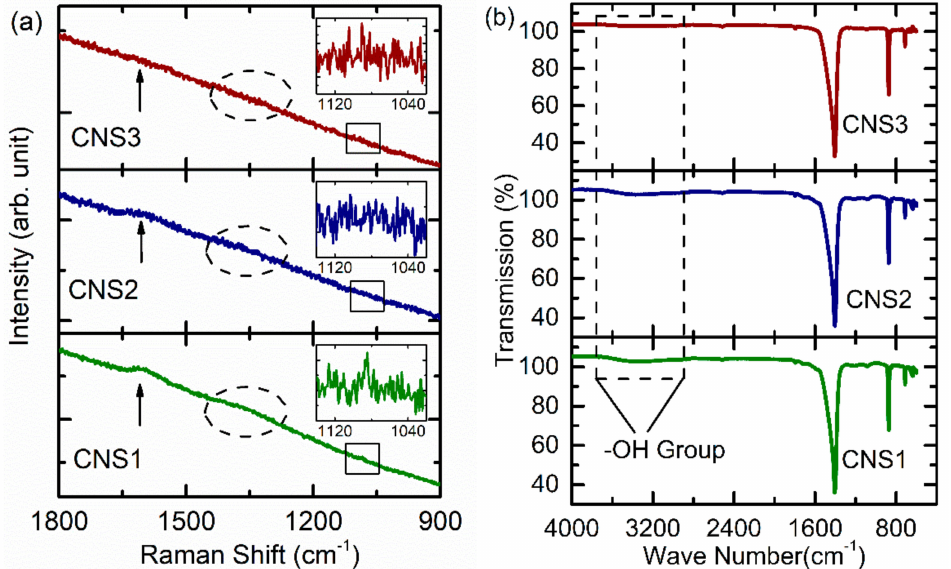
Figure 3a shows the background subtracted regions highlighted by